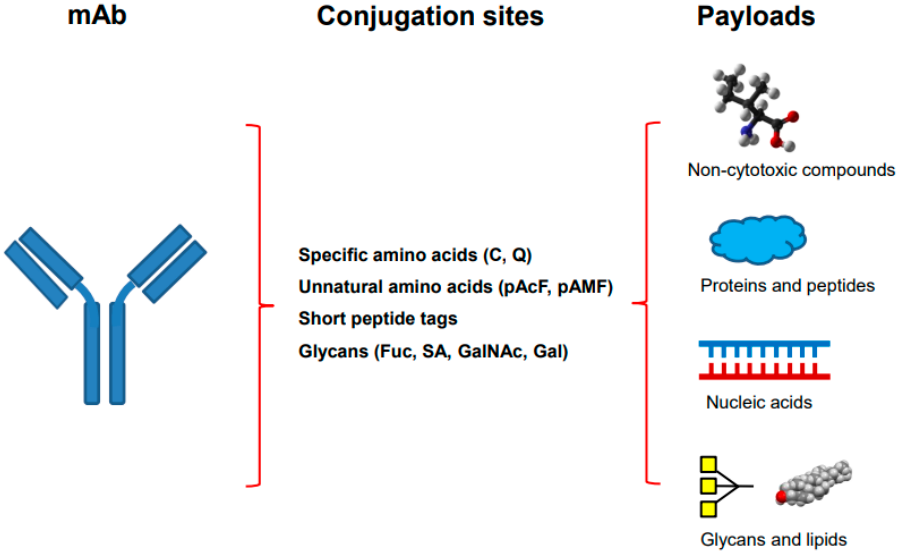
Figure 1. The site-specific antibody conjugation using payloads other than synthetic cytotoxins. The monoclonal antibody on the left is engineered by introducing different sites for selective coupling including specific amino acids, unnatural amino acids, short peptide tags, or modified glycans (middle). Different payloads, including non-cytotoxic compounds, proteins and peptides, nucleic acids, as well as glycans and lipids (right), are used for conjugation. Table 1. The four categories of the site-specific antibody–drug conjugation.